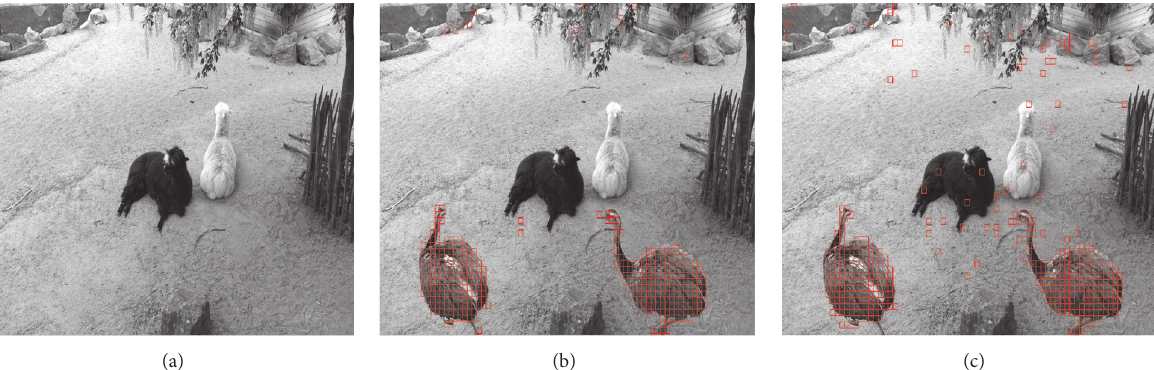
Figure 10: An example showing (a) an unaltered image and tampering detection results for (b) uncompressed and (c) JPEG compressed (QF = 95) tampering. The red box of size 64 × 64 indicates that this box is predicted as tampered by the proposed